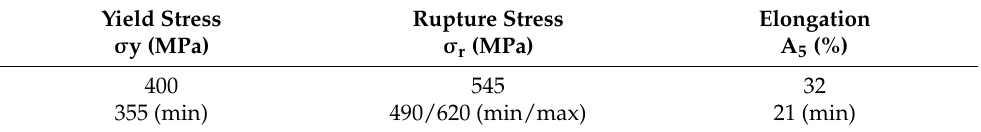
Table 3. Mechanical properties of the AH36